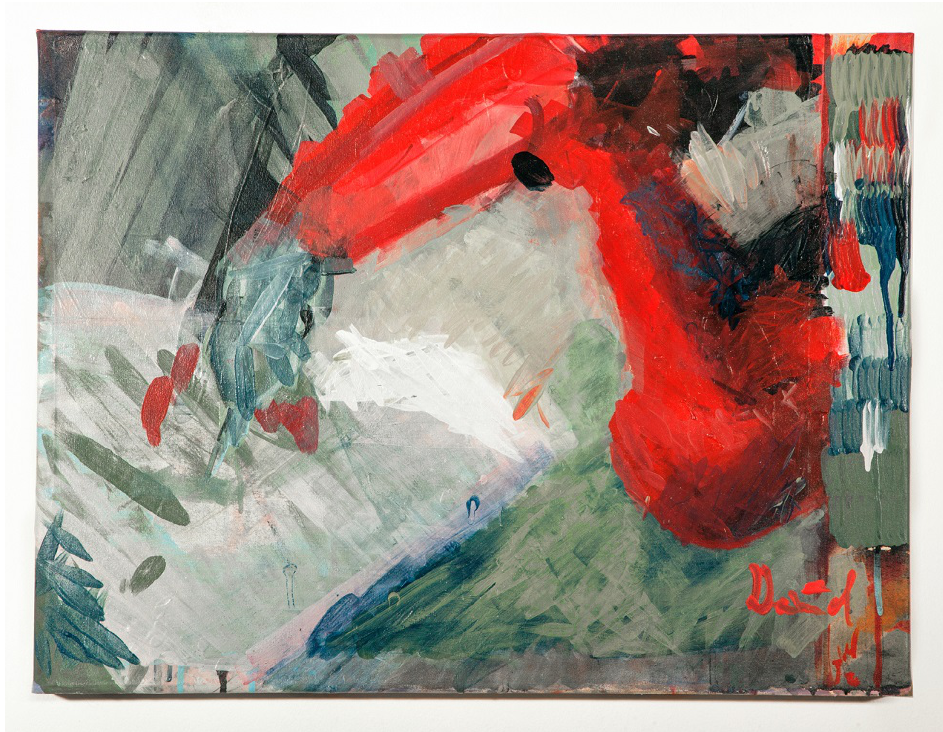
Figure A3. “e-David Self-portrait”, Acrylic on canvas, 60 cm × 80 cm, 2016, c (cid:13) Liat